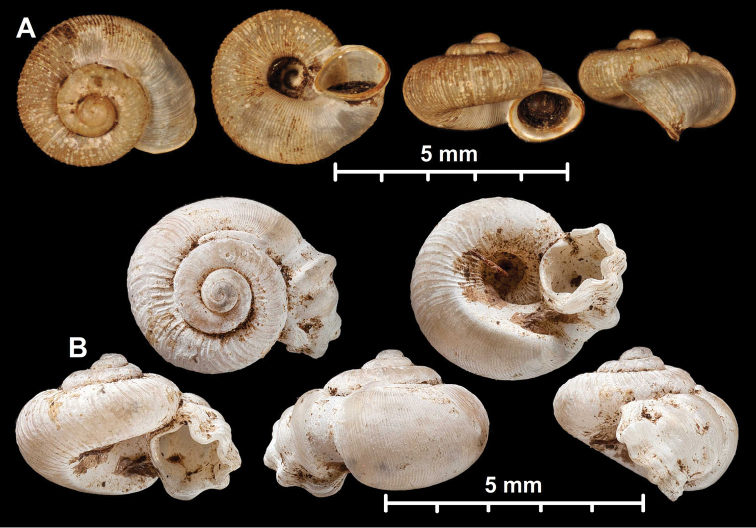
Type species of alycaeid genus-group taxa AAlycaeus
melanopoma Pilsbry, 1900 (synonym of Chamalycaeus
nipponensis (Reinhardt, 1877)), lectotype (ANSP 78815; type species of Metalycaeus); BMetalycaeus
magnificus (Godwin-Austen, 1914), syntype (NHMUK 1903.7.1.3115; type species of Raptomphalus). Photographs: downloaded from the website of ANSP (A), Harold Taylor (B).